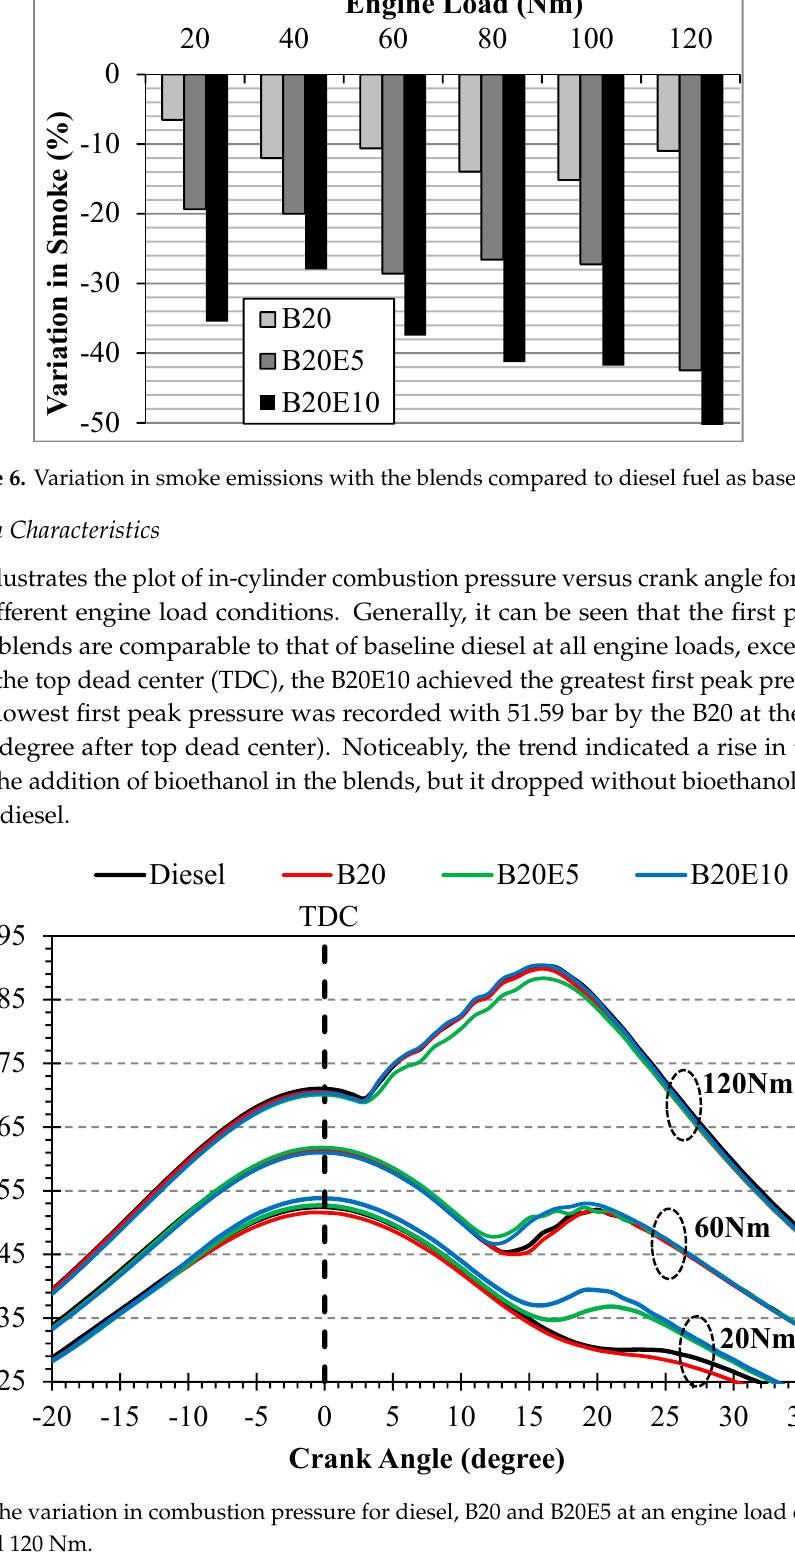
Figure 5. Variation in CO emissions with the blends compared to diesel fuel as a baseline. Smoke is generated from the incomplete combustion process in the CI engine, and it is definitely undesirable exhaust emission [66]. Figure 6 represents the variation in smoke emission in the form of percentage difference as compared with the baseline diesel at various engine loads. Based on the results obtained, all fuel blends tested showed a significant reduction in smoke emission across all engine loads. This is mainly due to the fact that bioethanol has less carbon and more oxygen than baseline diesel, promoting an increase of the oxygen/ fuel ratio and, consequently, improving the combustion process and resulting in lower CO emissions [67]. Also, the rich fuel-borne oxygen content in biodiesel and bioethanol blends promoted the oxidation of carbon atoms during the combustion process as reported in the literature [68–70]. Besides, the result also reveals that the